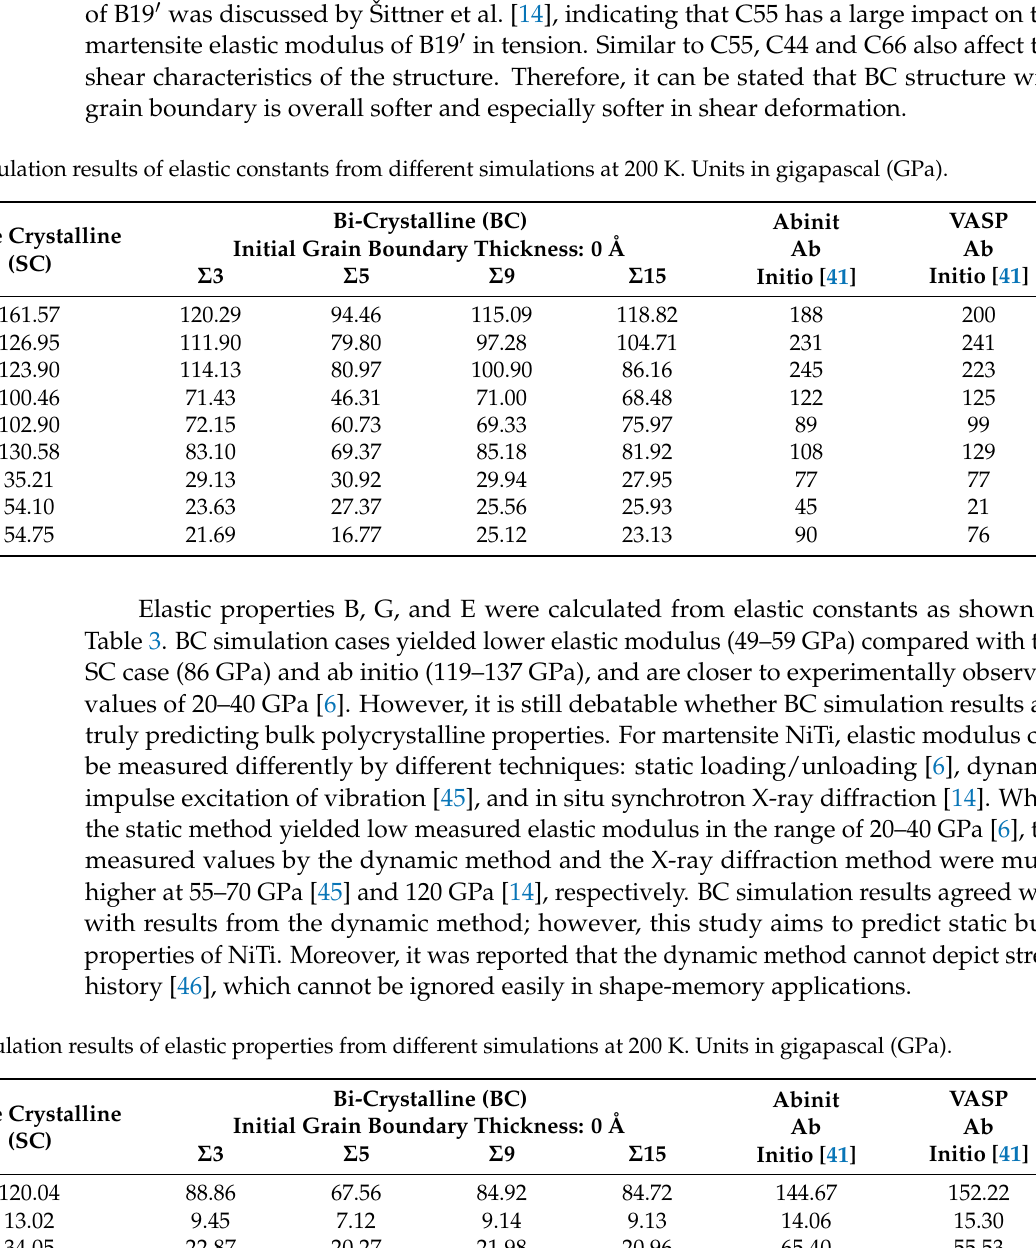
Table 2. Simulation results of elastic constants from different simulations at 200 K. Units in gigapascal (GPa). Single Crystalline Elastic Constants